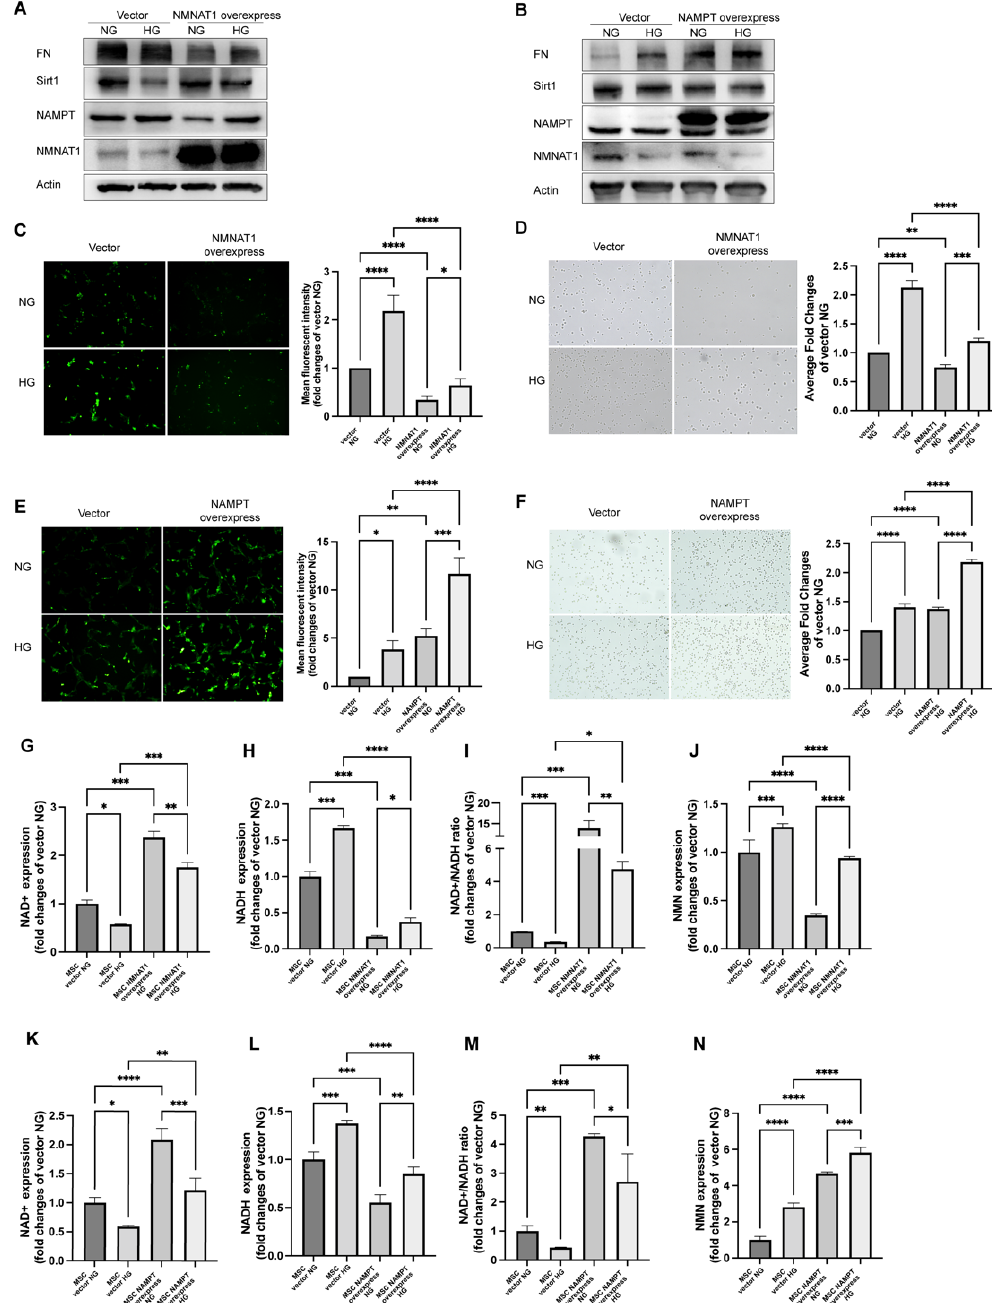
Figure 2. Effect of overexpression of NMNAT1 or NAMPT in MSC. Western blot analyzed NAD- related enzymes and fibrotic injury with or without 24 h HG in overexpressed NMNAT1 MSC ( A ) or overexpressed NMAPT MSC ( B ) for FN, Sirt1, NAMPT, and NMNAT1 levels; β -actin served as